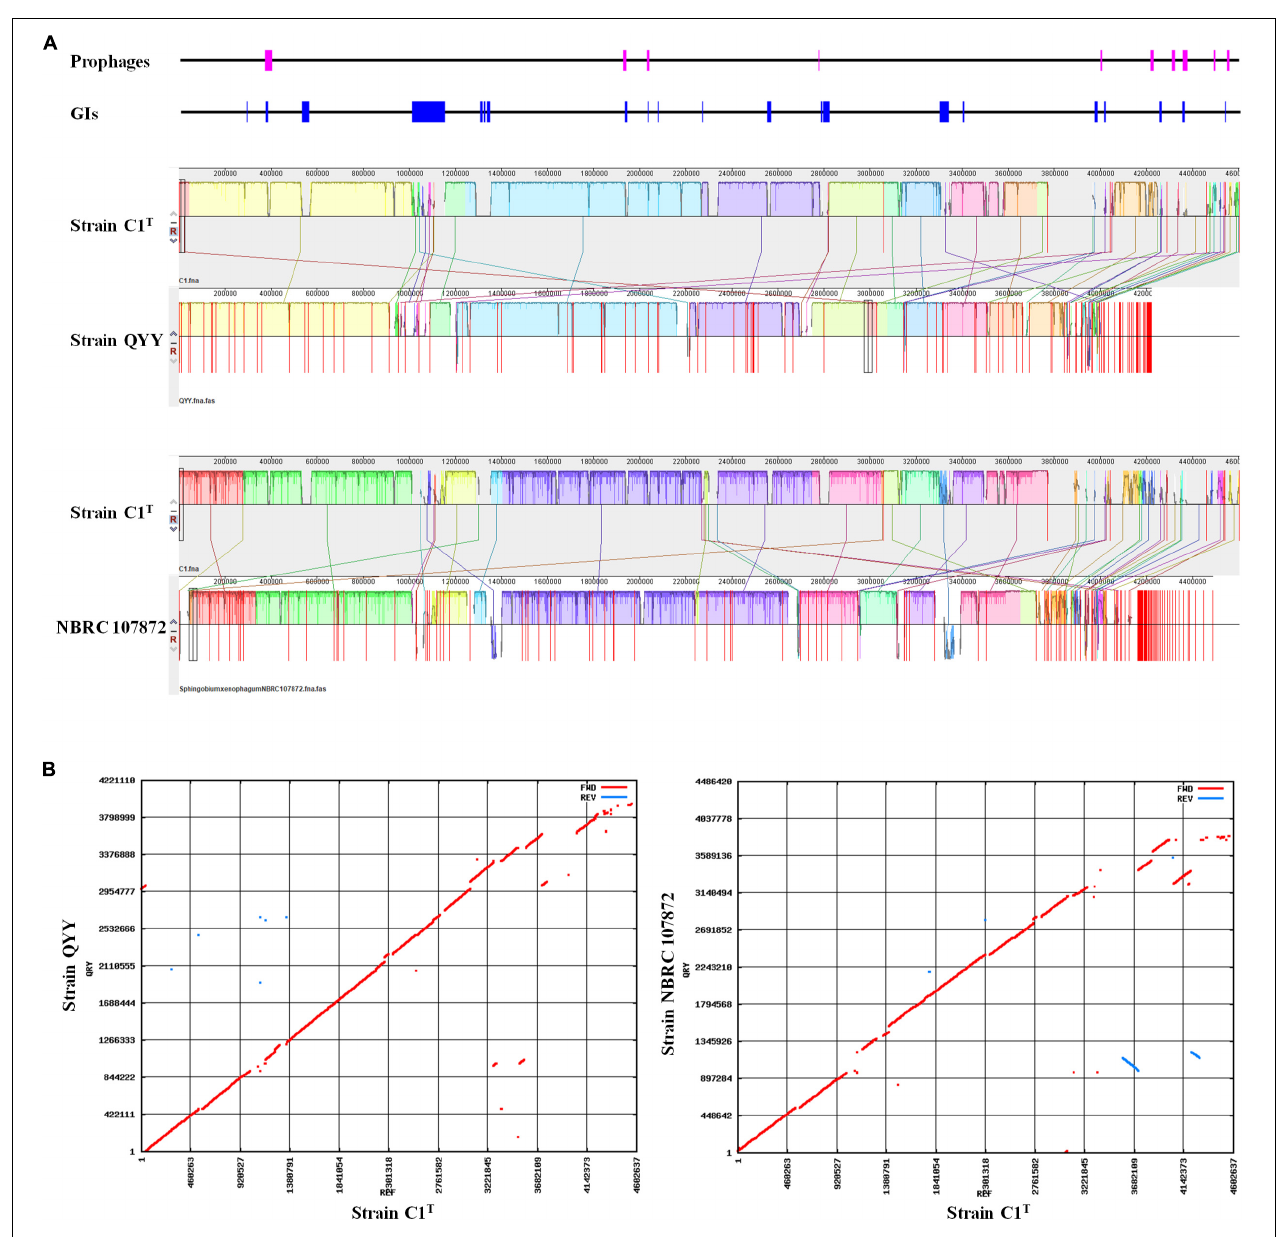
FIGURE 4 | Genome alignment of strains C1 T , QYY and NBRC 107872. (A) Genome alignment by Mauve. Each of colored blocks represents a presumably homologous region. Blocks above/below the center line respectively indicate aligned regions in the forward/reverse (reverse complement) orientation. The height of the similarity profile inside each block corresponds to the level of sequence conservation. The positions of prophages and GIs in the C1 T genome are shown correspondingly at the top. (B) Genome alignment by Mummer. Red/blue dots correspond to pairs of homologous sequences in the forward/reverse (reverse complement)